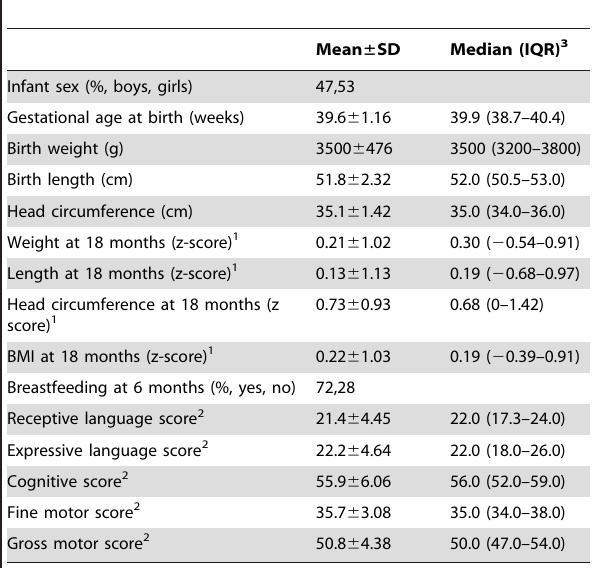
Table 3. Characteristics of infants assessed at 18 months of age.